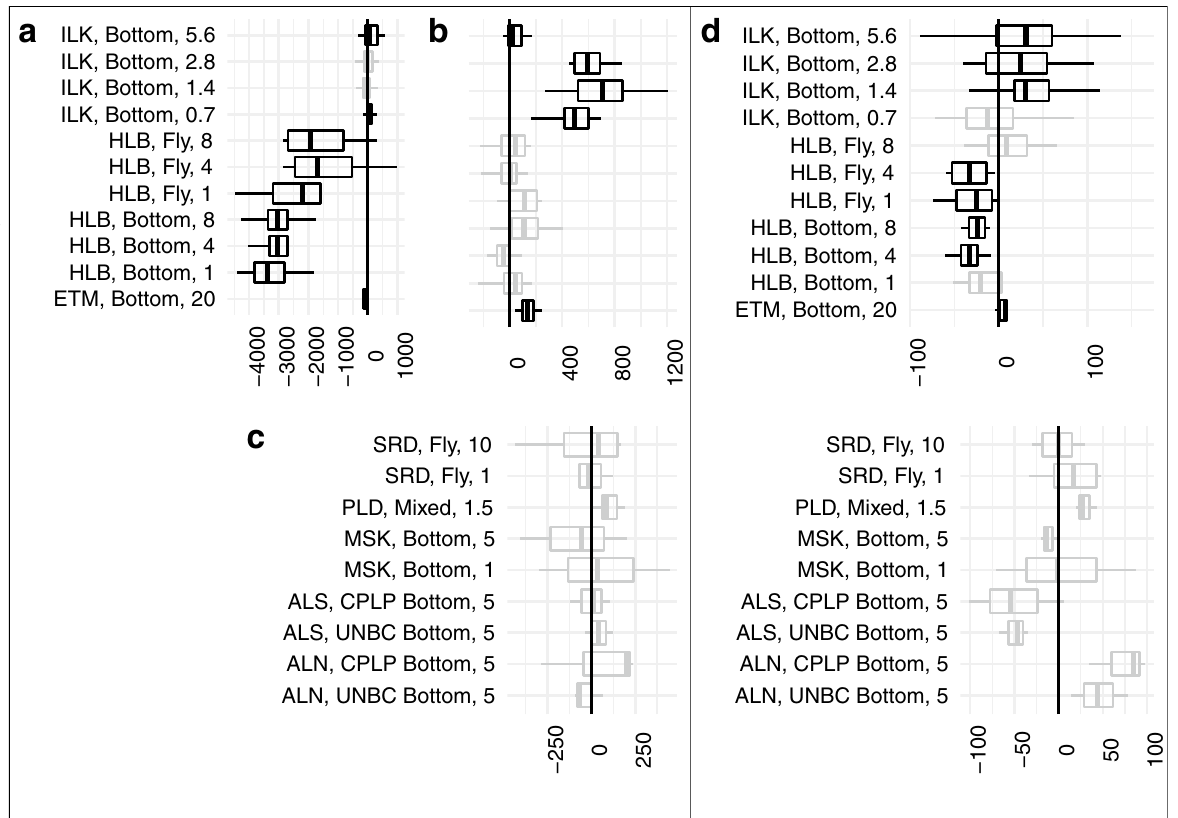
Figure 3. Differences in N -acetyl-glucosamine activity between treatments and controls.Results significantly different than zero as determined by Wilcoxon-test are shown with (Bonferonni corrected p < 0.05) or ( p < 0.05), results that were not significant are shown with . Panels show different soil horizons a = L, b = FH, c = LFH, d = 0–10 cm of mineral